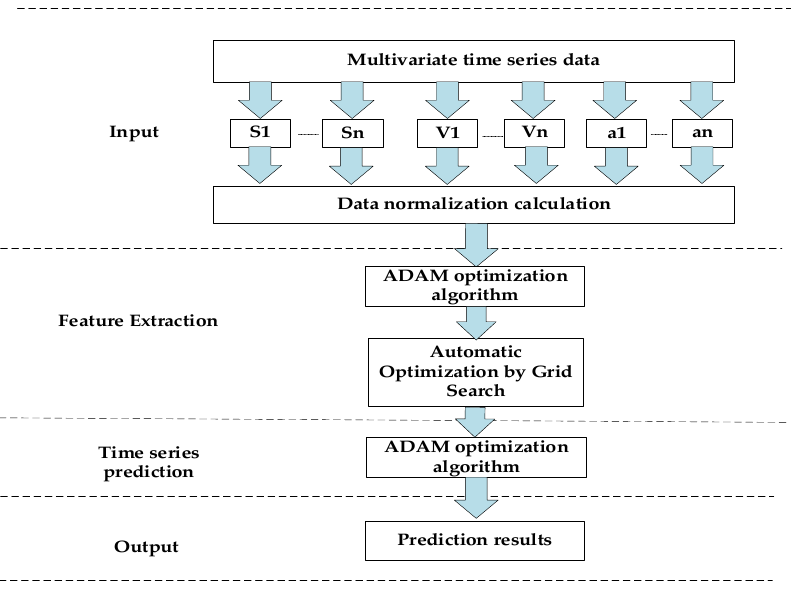
Figure 7. Predictive model framework.